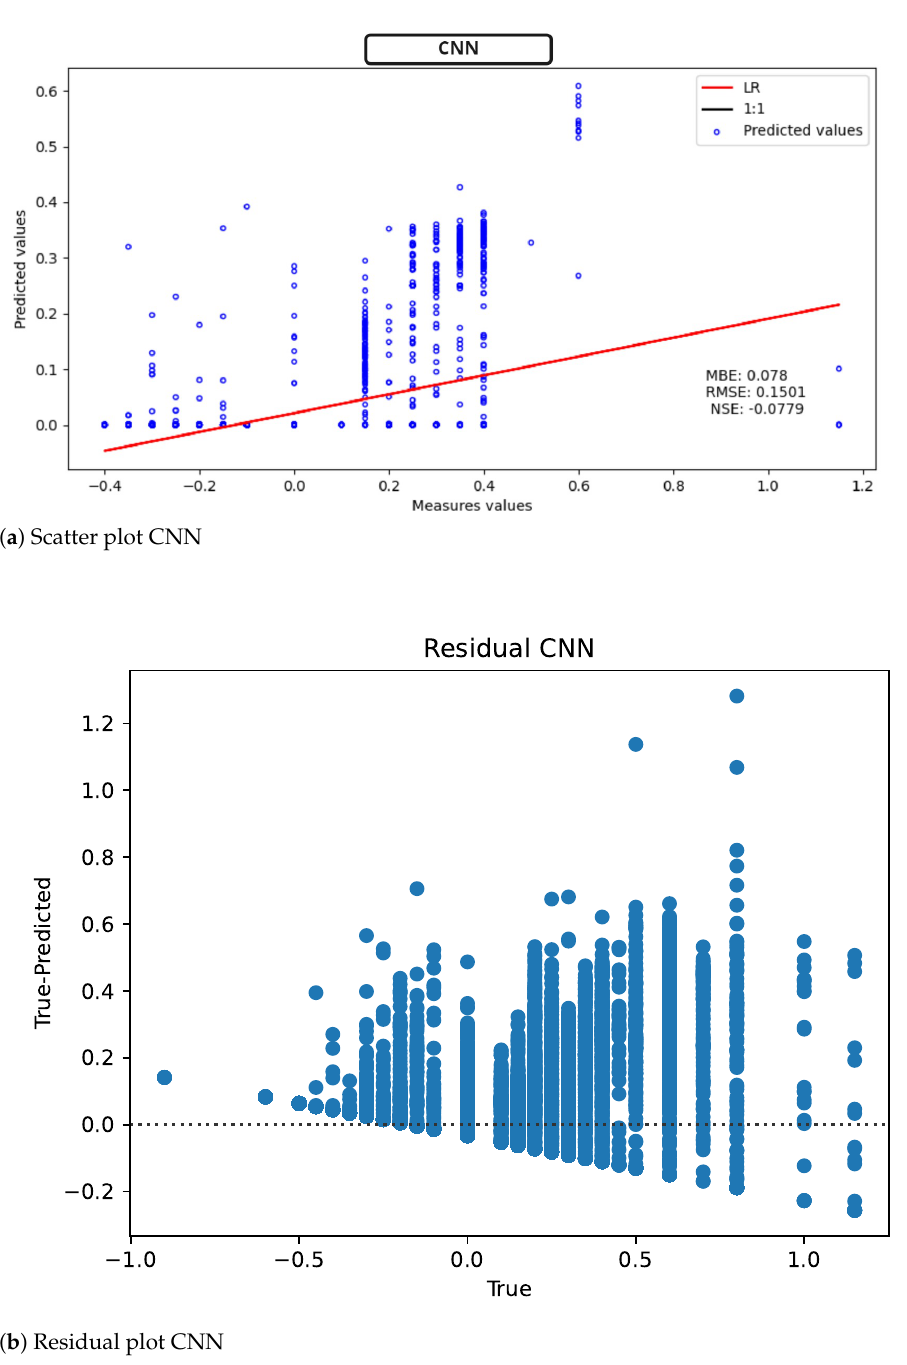
Figure 12. CNN results for ST deviation calculation in ECG time